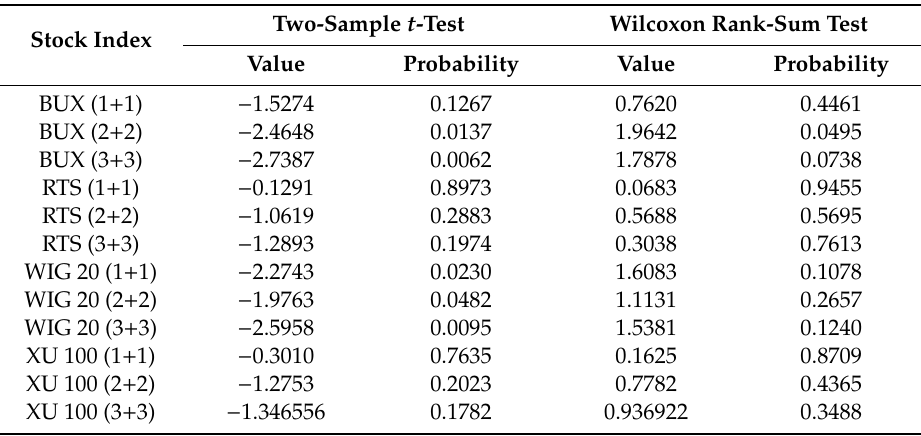
Table 5. Results of the statistical significance tests—Daily volatilities (alternative 1).